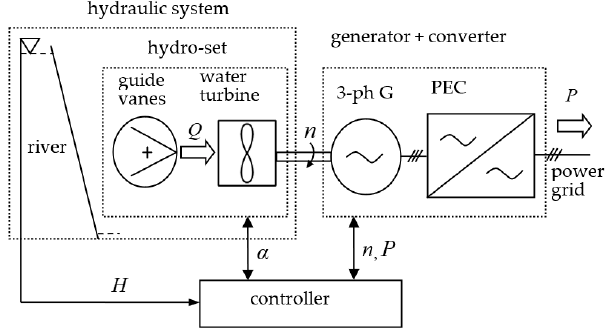
Figure 1. Schematic diagram of the energy conversion system of a variable speed small hydropower plant (SHP).